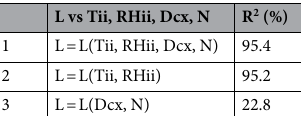
L vs Tii, RHii, Dcx,